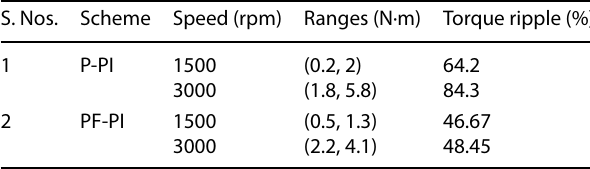
Table 7 The torque ripple ranges under different schemes S. Nos. Scheme Speed (rpm) Ranges (N∙m) Torque ripple (%)